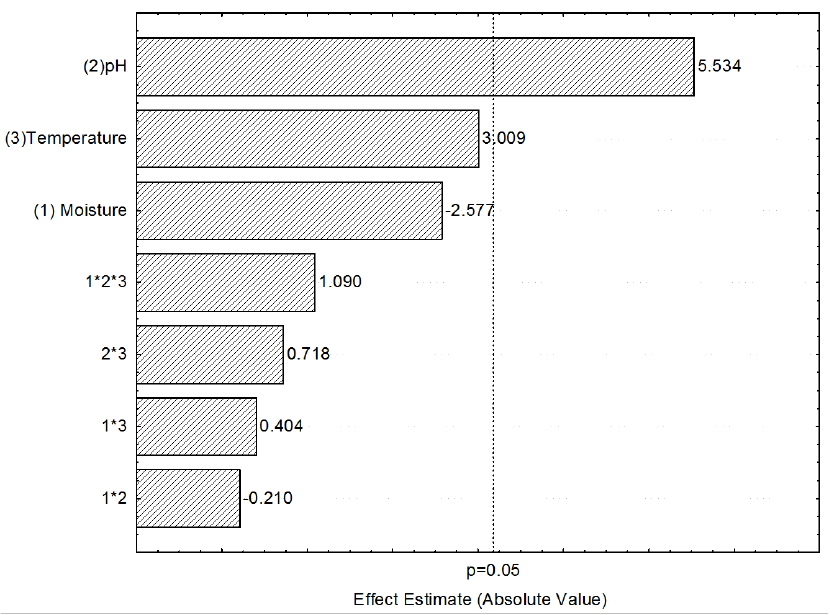
Figure 1. Pareto chart of main effects showing the production of Phytase during the 48 hours of fermentation of citrus pulp using three variables at two levels. The numbers in the ordinate of the figure refer to: (1) Moisture - percentage of water content, (2) pH and (3)